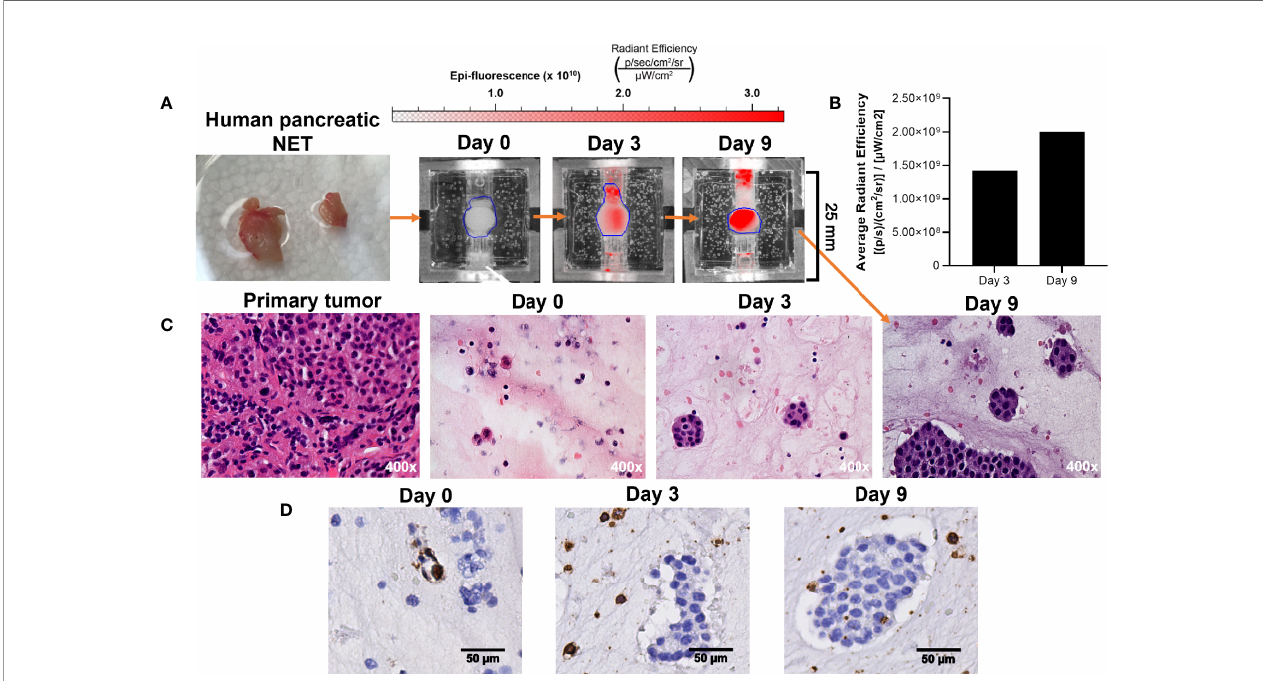
FIGURE 8 | Growth of patient-derived NET surrogates is detectable using IR-783 and is consistent with increased density of NET cells histologically. (A) A human pancreatic NET was implanted into 3 separate bioreactors fi xed at days 0, 3, and 9. (B) IVIS fl uorescence imaging of the surrogate fi xed at day 9 was performed on days 0, 3, and 9. Region of interest measurement of fl uorescent signals depict a 41% increase in average radiant ef fi ciency between days 3 and 9. (C) Photomicrographs of H&E stained histologic sections from the primary tumor and its surrogates following 0, 3 and 9 days in culture were acquired. Histological sections of surrogates depict epithelial clustering characteristic of NETs and increasing cell density from 0 to 9 days. (D) CD45 immunostaining of the bioreactors depicted in (B) identi fi es the retention of host immune cells within the proliferating tissue